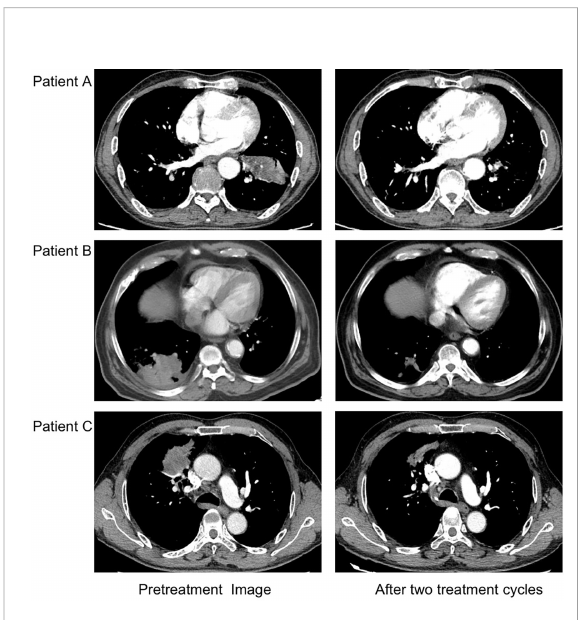
FIGURE 1 CT images of lesions before and after two cycles of neoadjuvant camrelizumab plus chemotherapy. After two doses of camrelizumab plus chemotherapy, the lesions of three patients were signi fi cantly reduced.